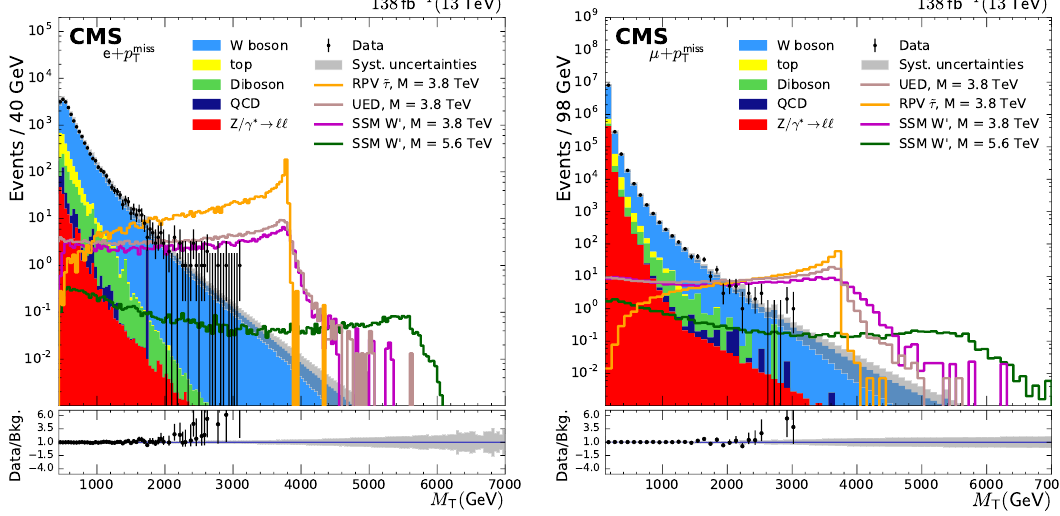
for the electron (left) and muon (right) channels after applying Figure 4 . The distributions for M T the full selection criteria, for the combined 2016–2018 data sets. Contributions from the SSM W 0 , split-UED W (2) , and RPV SUSY signals at the masses of 3.8 and 5.6 TeV are also indicated. e t KK The lower panels show the ratios of data to the SM prediction, and the shaded bands represent the systematic uncertainty.